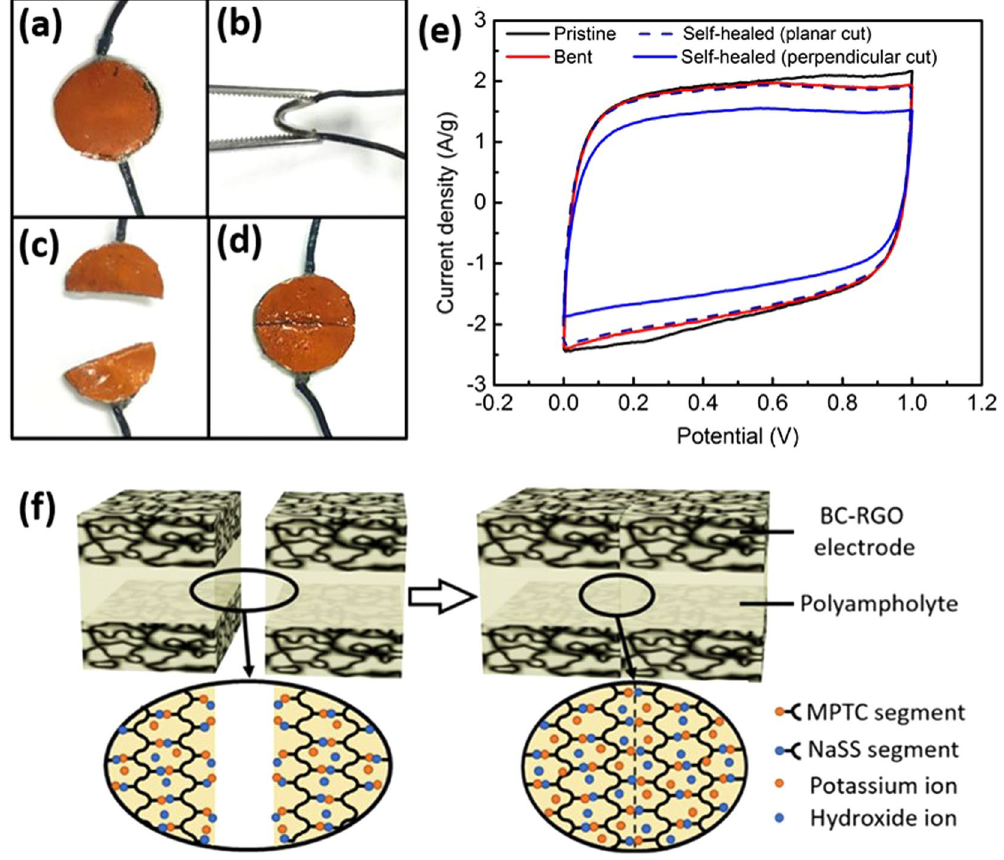
Figure 6. Photographs of ( a ) pristine, ( b ) bent, ( c ) broken, and ( d ) self-healed supercapacitor (SC-PA). ( c , d ) show the procedure for the perpendicular cut. The procedure for the planar cut is described in supporting information. ( e ) Cyclic voltammetry (CV) profile of pristine, bent and self-healed (perpendicular and planar cuts) SC-PAs at a scan rate of 20 mV s − 1 . ( f ) Schematic illustration of polyampholyte hydrogel self-healing for the perpendicular